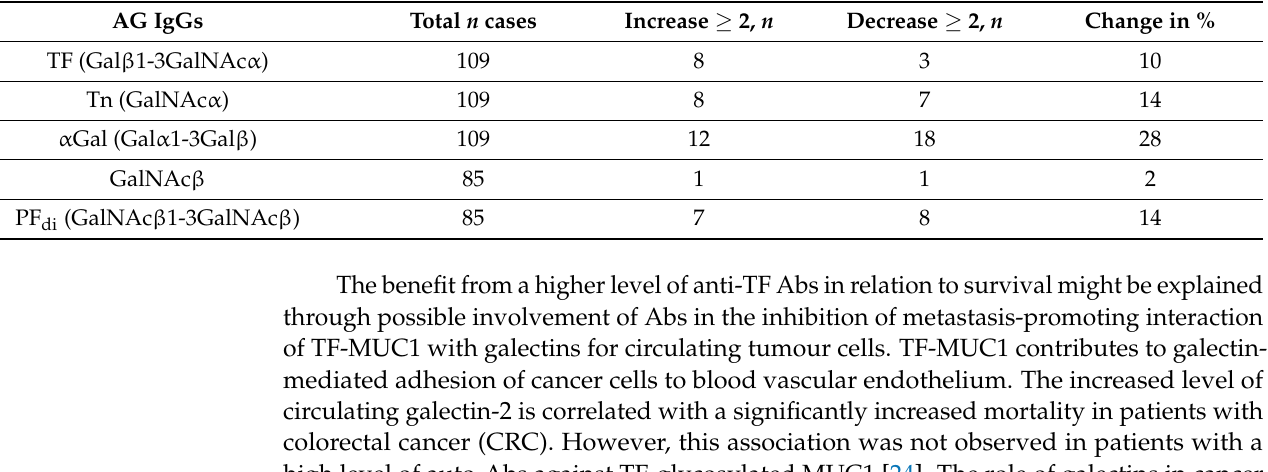
Table 1. Twofold or more changes of the AG Abs level in the monitoring of gastrointestinal cancer patients (presented for the first